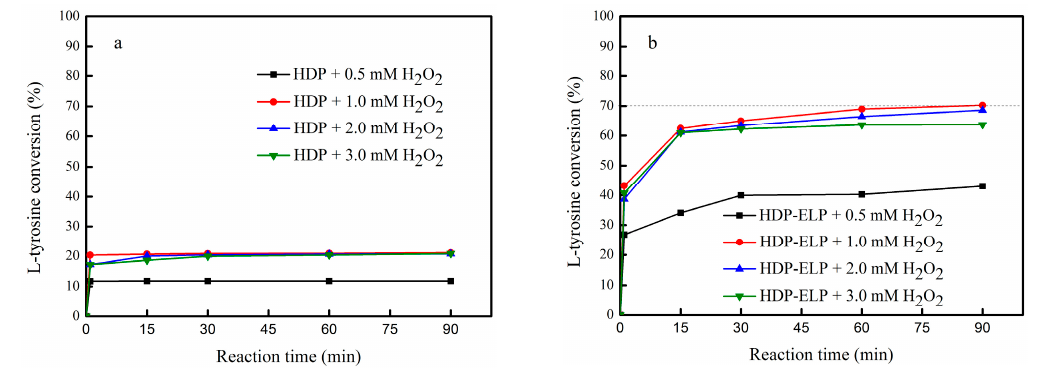
Figure 5. L ‐ Tyrosine conversion by HDP and HDP ‐ ELP with various concentrations of H 2 O 2 . ( a ) By HDP catalysis; ( b ) by HDP ‐ ELP catalysis. The reaction temperature is 30 °C.